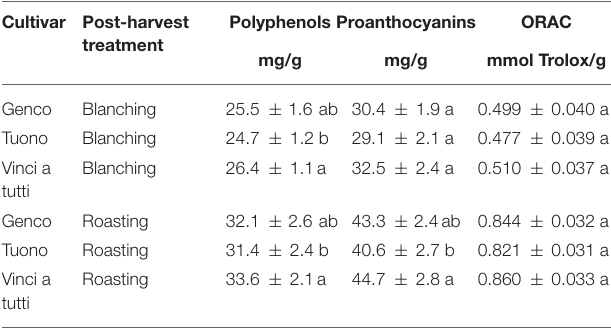
TABLE 2 | Total polyphenols in the seed skin of three Italian almond cultivars at harvest. Cultivar Post-harvest treatment